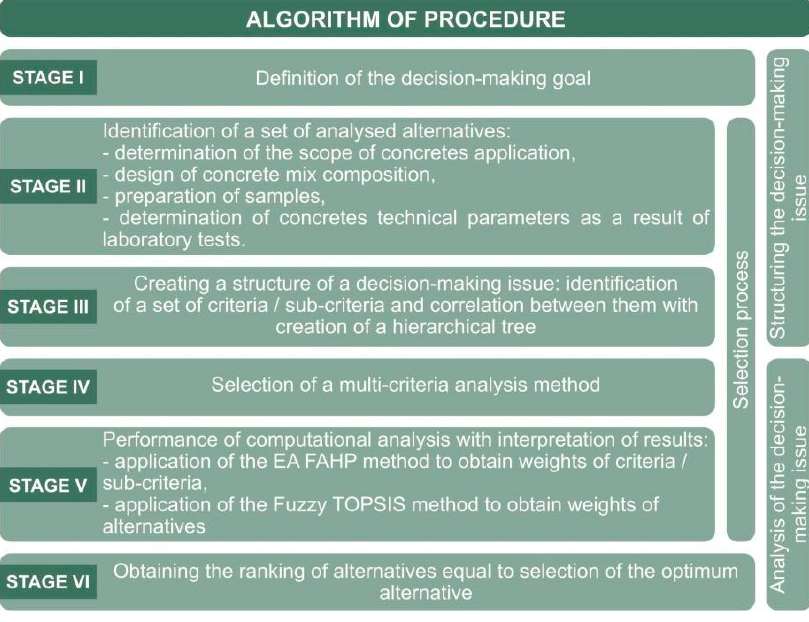
Figure 1. Procedure algorithm for selection of the optimum concrete mix for post-tension girder bridges.